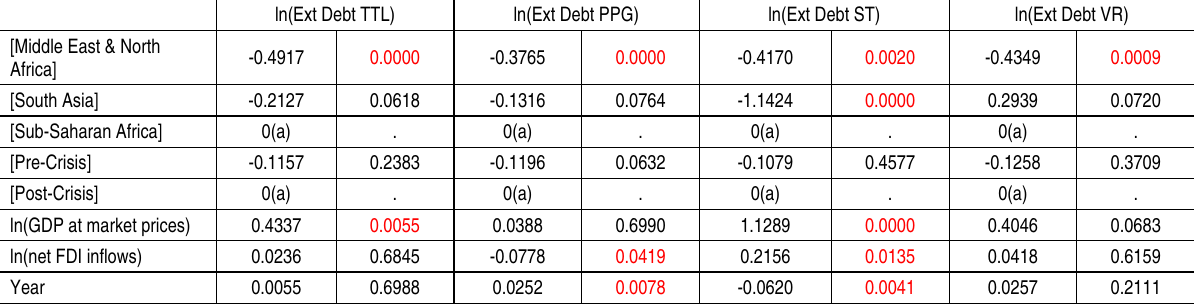
Table 10 (cont.). Fixed effects panel regression for total external debt, PPG external debt, ST external debt, and VR external debt